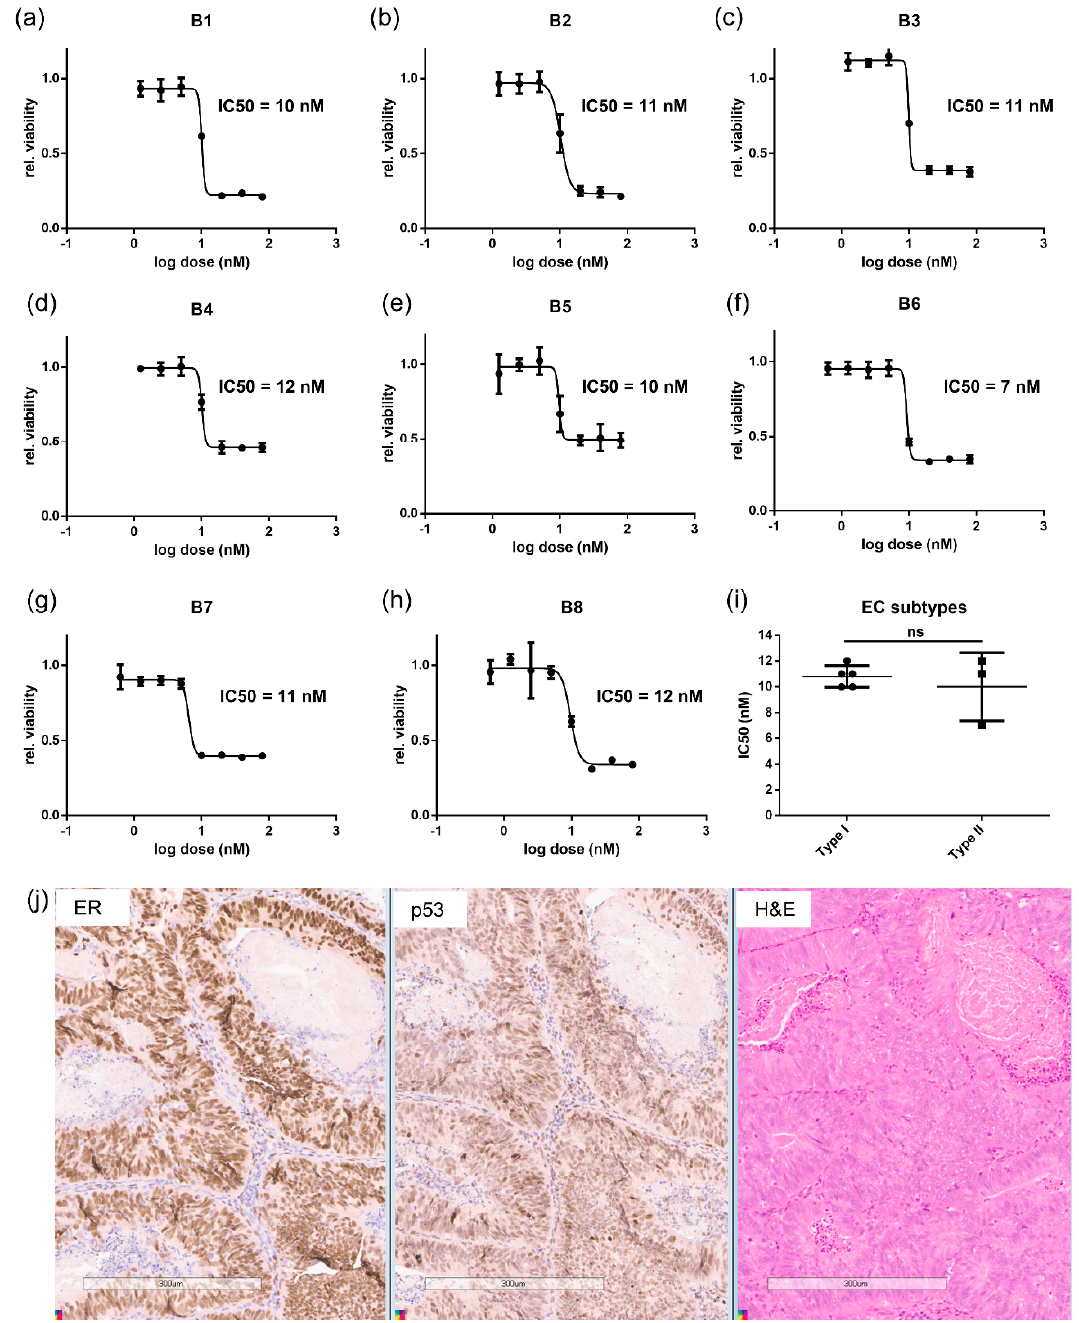
Figure 2. Dinaciclib is effective at inhibiting growth of primary endometrial tumor cells isolated from EC patients. Dose– response following 72 h of treatments with dinaciclib in tumor cells isolated from eight EC tumors, labeled in the graphs as B1 to B8 ( a – h ). Viability was measured using a RealTime-Glo MT Cell Viability Assay and normalized to vehicle controls. ( i ) A comparison of the IC50s of tumor cells derived from Type I (B1, B2, B5, B7, B8) and II (B3, B4, B6) tumors. ( j ) Immunohistochemical (IHC) panel showing, from left to right, ER, p53, and H and E (hematoxylin and eosin), staining of EC biopsy tissue, Scale Bar is 300 μ m. Statistical significance was calculated using the unpaired t -test. ns = not significant